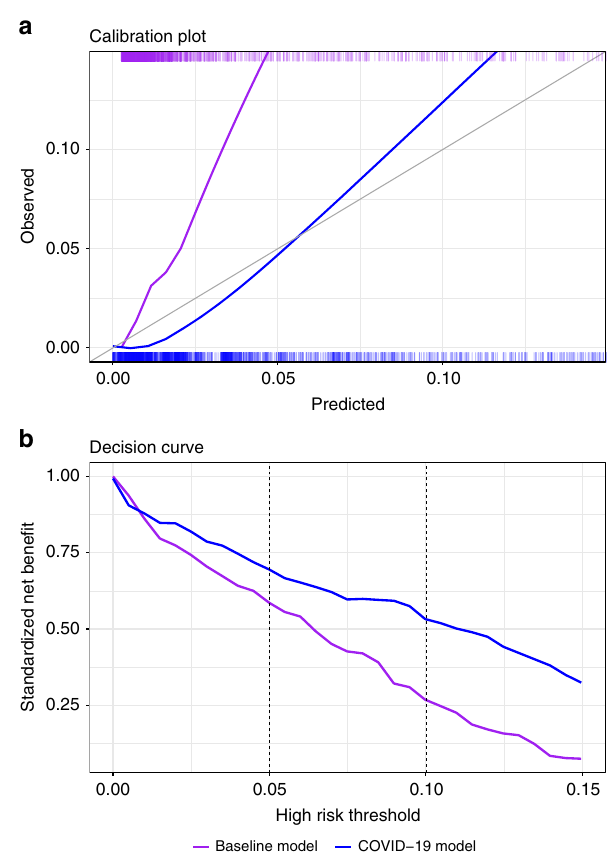
Fig. 4 Calibration plot and decision curves comparing the COVID-19 and baseline models. a Calibration plots plotting the observed outcome against the predicted probabilities of both models. The diagonal gray line represents perfect calibration. A smoothed line is fi t to each curve. The rug above and under the plots illustrates the distribution of predictions for each model. The plot covers 95% of COVID-19 predictions. b The decision curve plots the standardized net bene fi t against different decision thresholds for both models. Net bene fi t is a measure of utility that calculates a weighted sum of true positives and false positives, weighted according to the threshold. Vertical dashed lines were added at relevant decision thresholds that were used in practice. Both panels use the COVID-19 patient population, n = 4179 unique patients. COVID-19 coronavirus disease